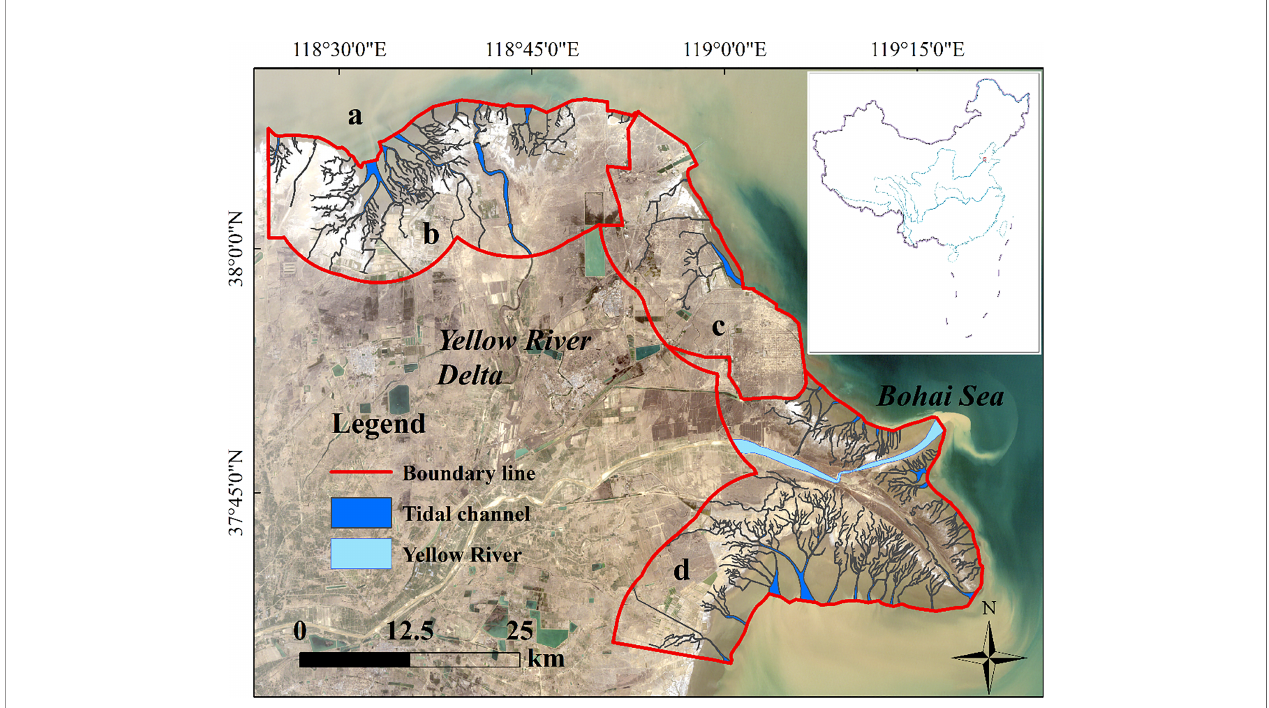
FIGURE 1 | Landsat image (TM5) of the study area in April 8th, 2000 ( A represent the whole scale of delta, B – D represent the erosion zone, oil fi eld zone and deposition zone